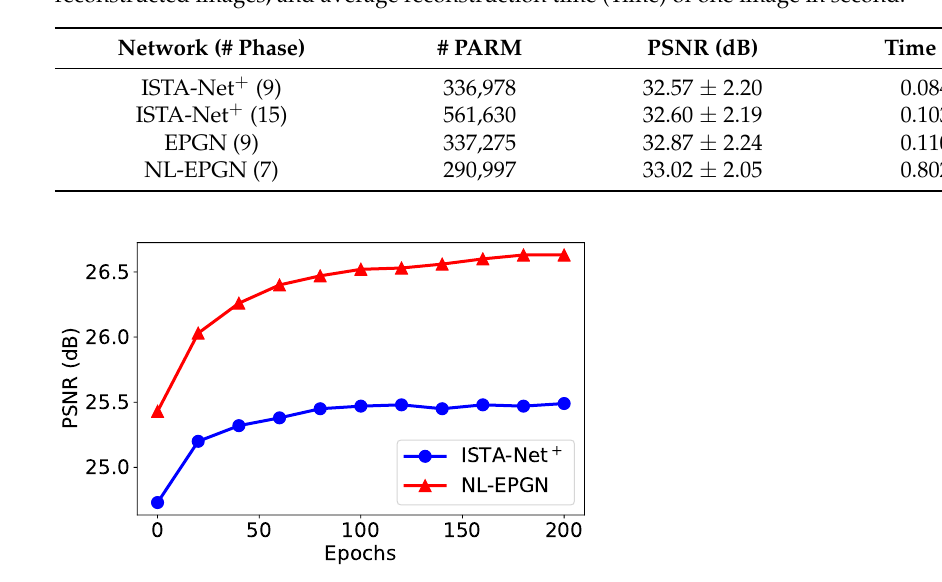
Figure 8. Average PSNR comparison between ISTA-Net + and NL-EPGN with various numbers of epochs during training with 3 phases on Set11 with a CS ratio of 10%.